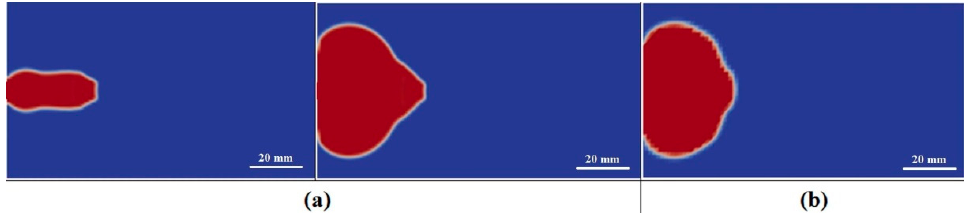
Figure 6. Melt shapes near the gate in the initial filling stage for gate locations at ( a ) 1 mm; and ( b ) 0 mm away to mold wall.